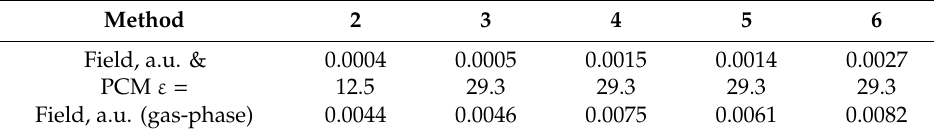
Table 3. The external electric field at which the energy minima of the molecular (O-H ··· N) and ionic (O − ··· [H-N] + ) forms of H-bonds in 2 – 6 are equal.